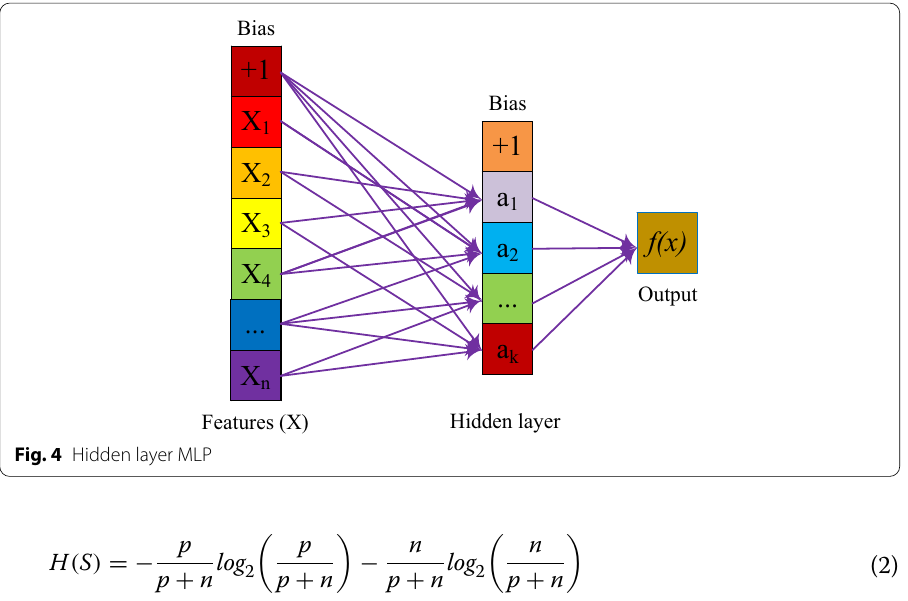
Fig. 4 Hidden layer